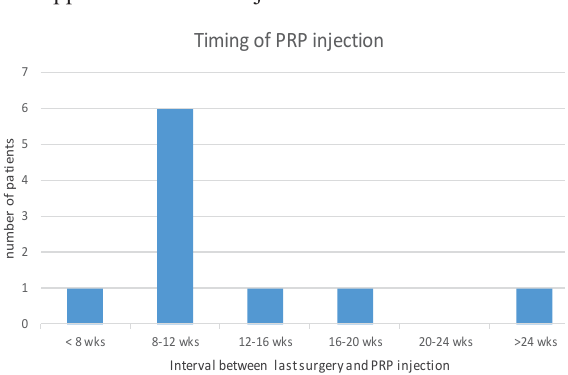
Most of the patients received PRP injection between eight and twelve weeks of last surgery ( Figure 5 ). The mean duration between the last surgical procedure and application of PRP injection was 14±5.6 weeks.